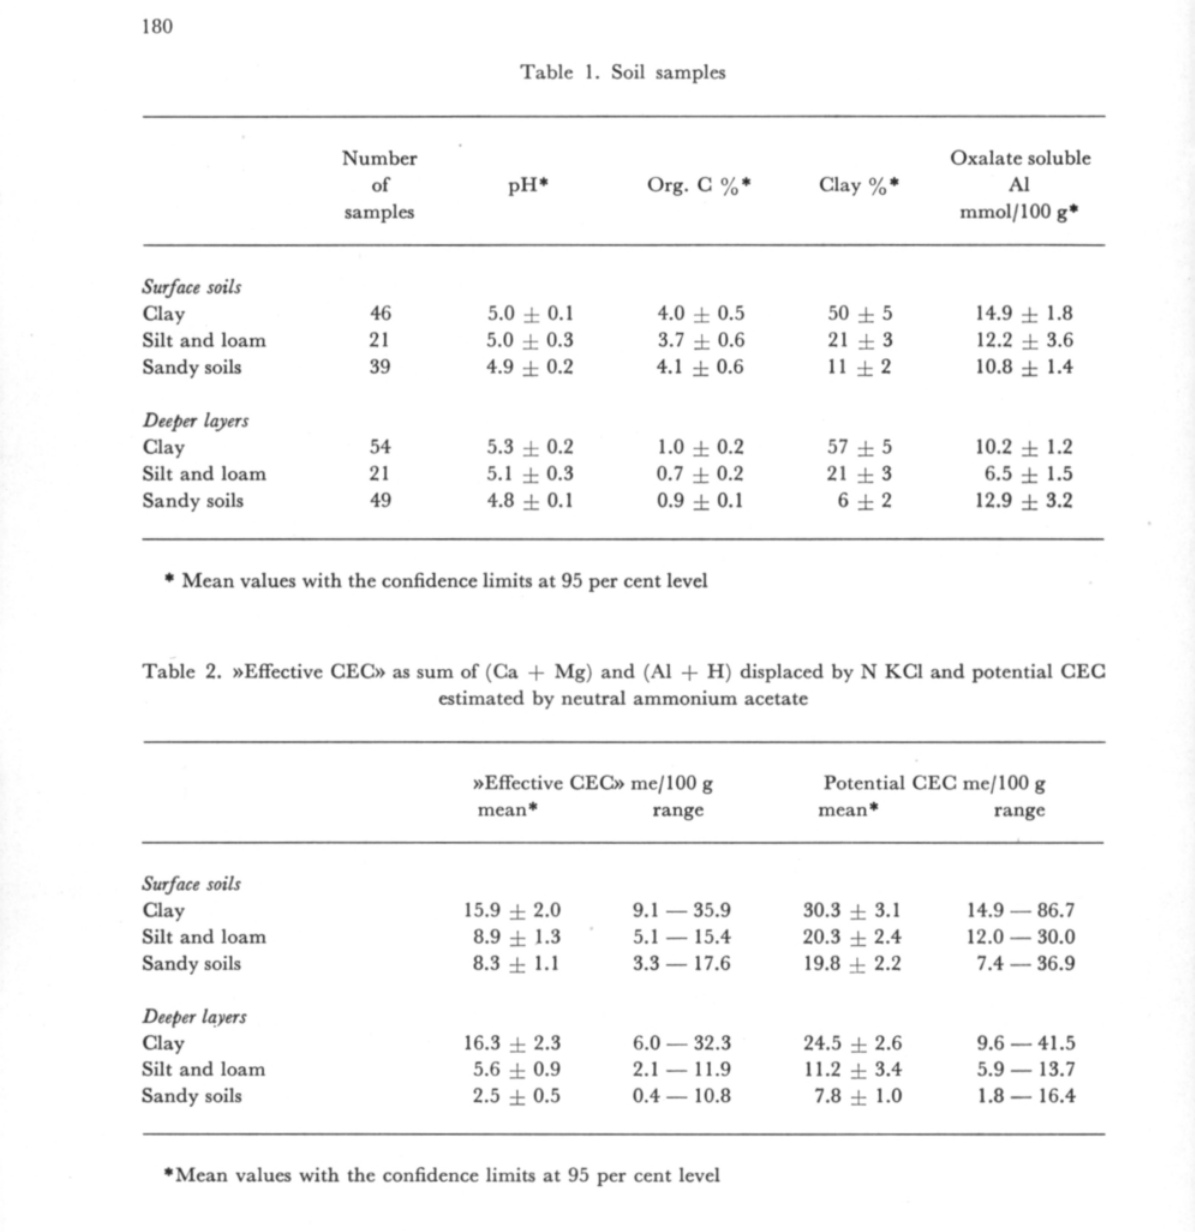
Table 1. Soil samples